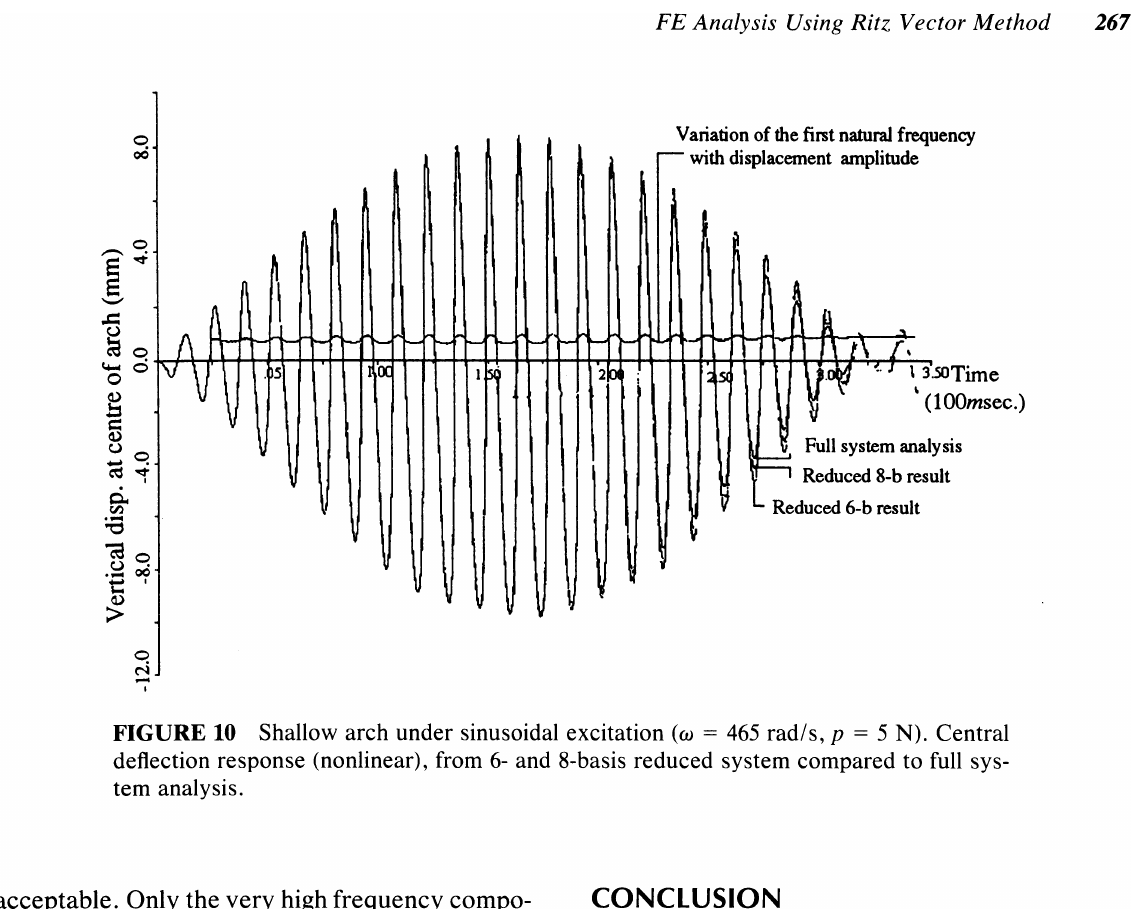
FIGURE 10 Shallow arch under sinusoidal excitation (w = 465 rad/s, p = 5 N). Central deflection response (nonlinear), from 6- and 8-basis reduced system compared to full sys tem analysis.